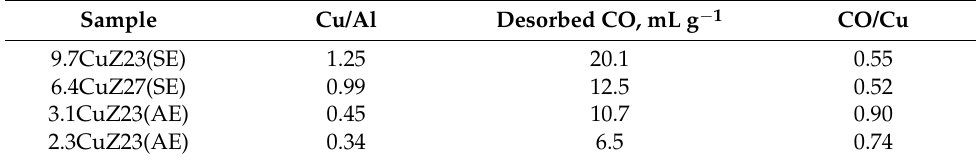
Table 3. CO adsorption capacity of the Cu/ZSM-5